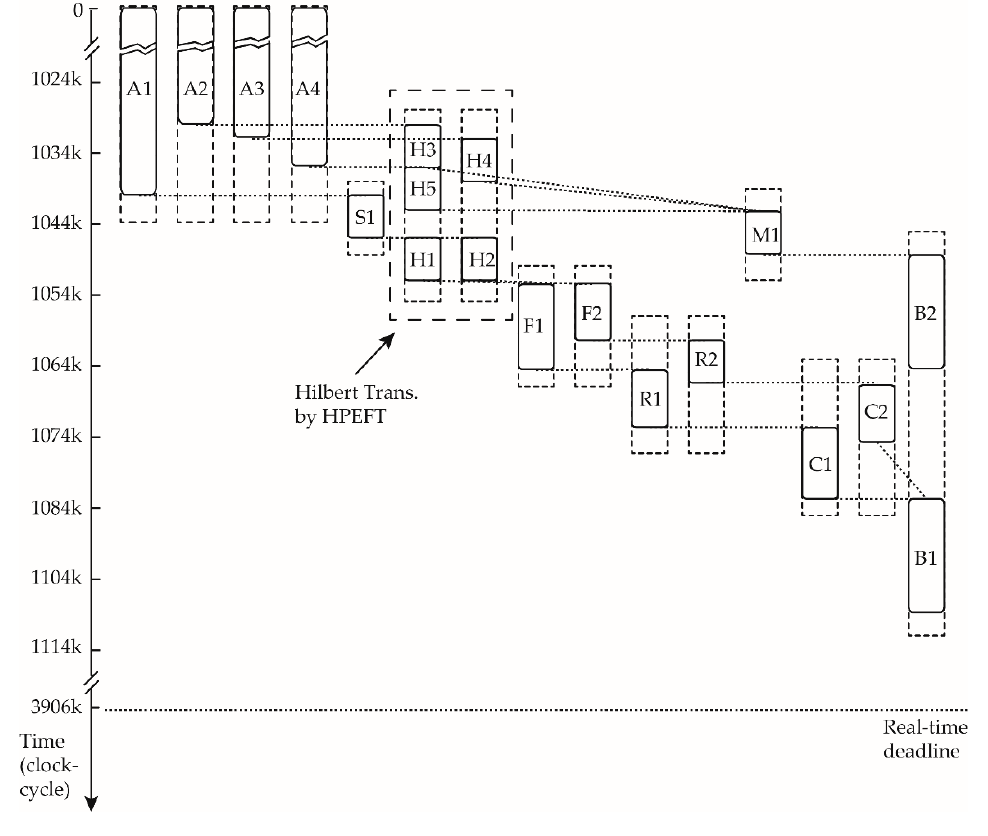
Figure 14. Gantt chart after scheduling multiple groups of scanning tasks by HPEFT.